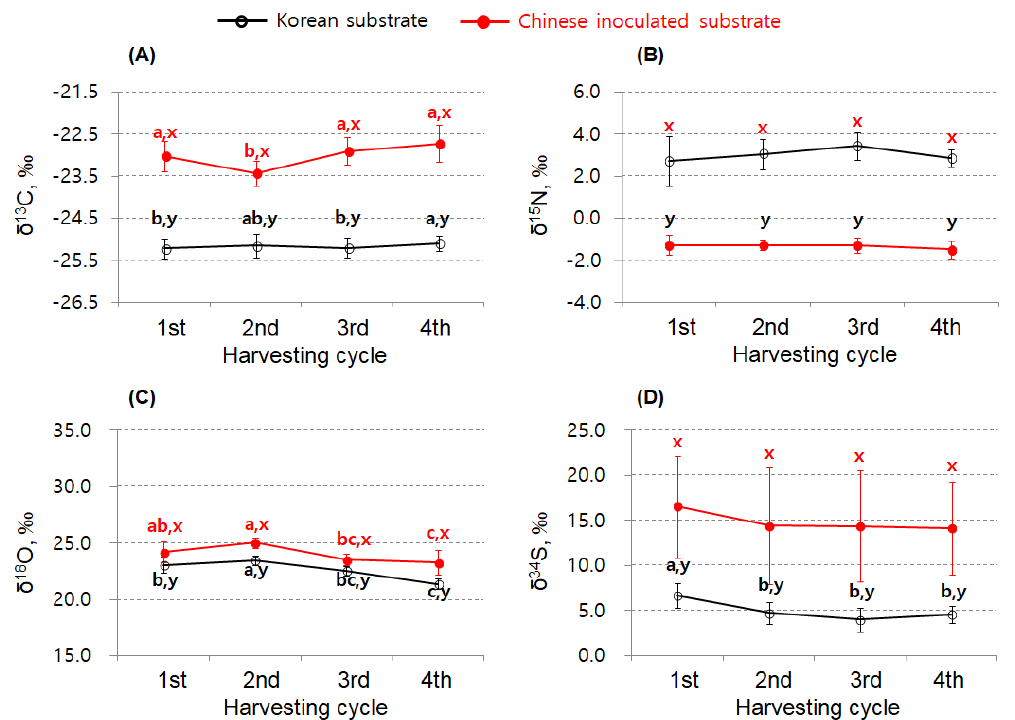
Figure 6. Comparison of δ 13 C, δ 15 N, δ 18 O, and δ 34 S variations based on the harvesting cycle in shiitake mushrooms cultivated using Korean or Chinese substrate. Values with different superscripts significantly differ with respect to the harvesting cycle (a–c) or substrate origin (x, y). The δ 13 C ( A ), δ 15 N ( B ), δ 18 O ( C ), and δ 34 S ( D ) indicate the variations according to the harvesting cycle between Chinese inoculated and Korean substrate.